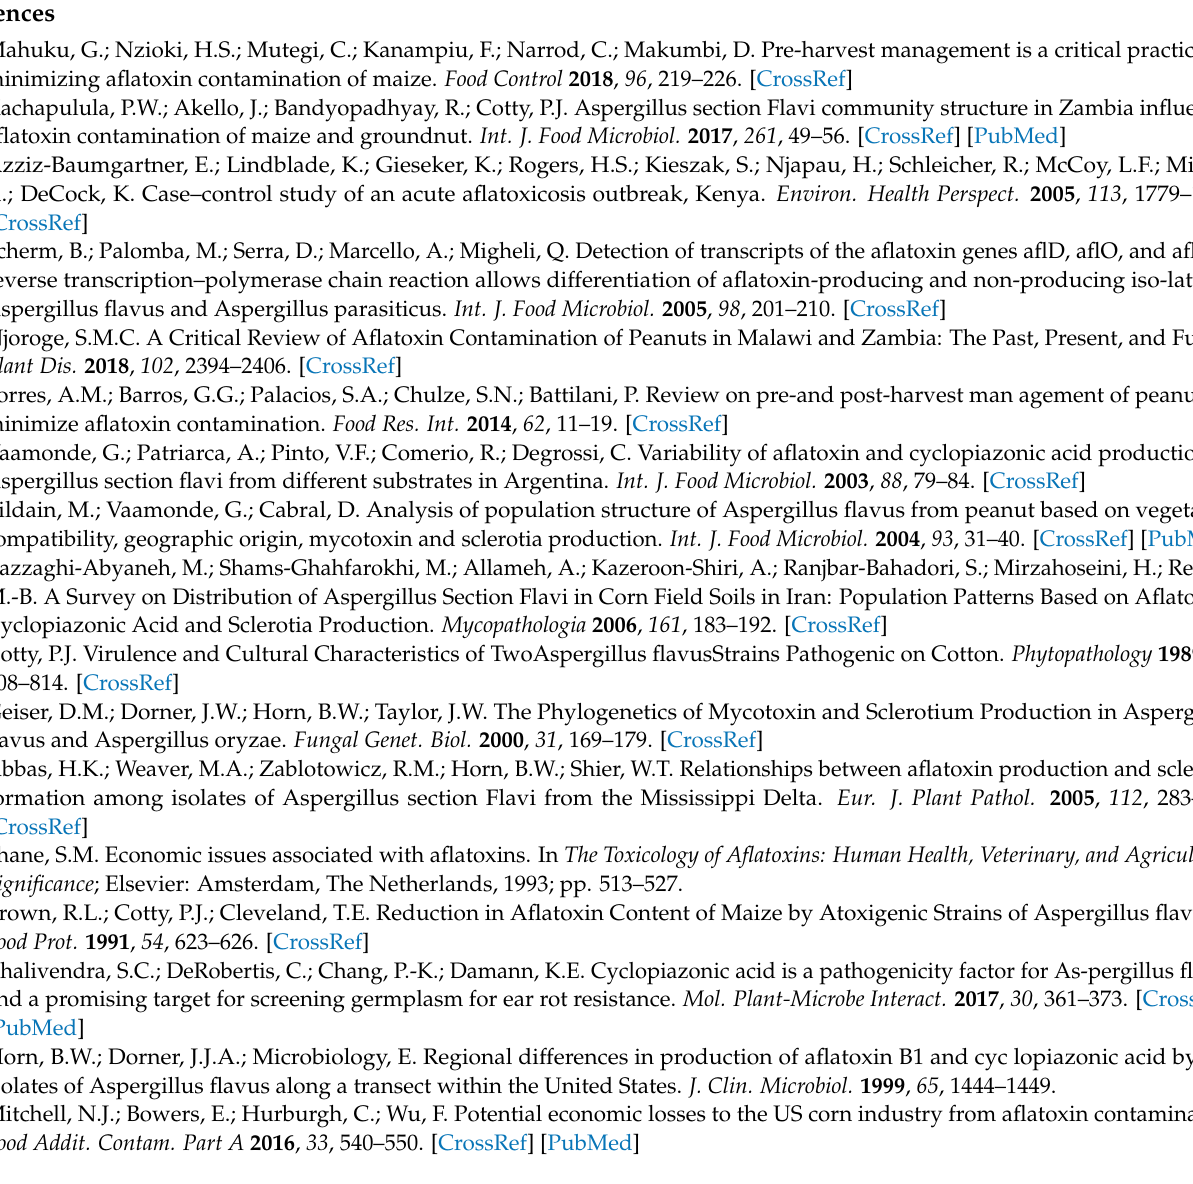
3357 with co-inoculation of different proportions of atoxigenic strains on peanuts at 30 ◦ C for 14 d; Figure S5: Determination of aflatoxin content in peanut cultured for 14 d by TLC; Table S1: Reduction of AFB 1 content by co-inoculation with atoxigenic A. flavus